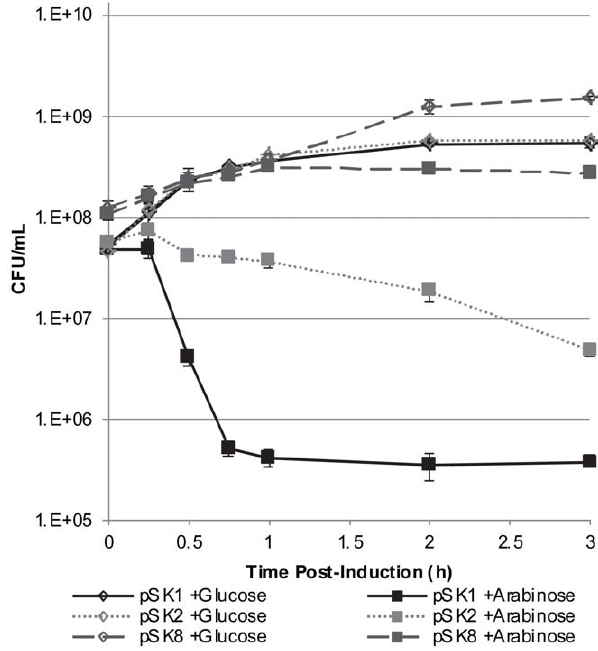
Figure 4. The srSm RNA represses GFP expression. Fluorescence from plasmid-encoded DRI/II- gfp (pSK4) or D DRI/II- gfp (pSK5) transcrip- tional fusions was measured in E. coli DH10B carrying pHSG299 vector expressing srSm (pSK6) or the empty vector. The promoterless GFP vector (pSK3) was used as negative control. All experiments were performed in triplicate from two independent experiments. The means 6 SDs are shown.